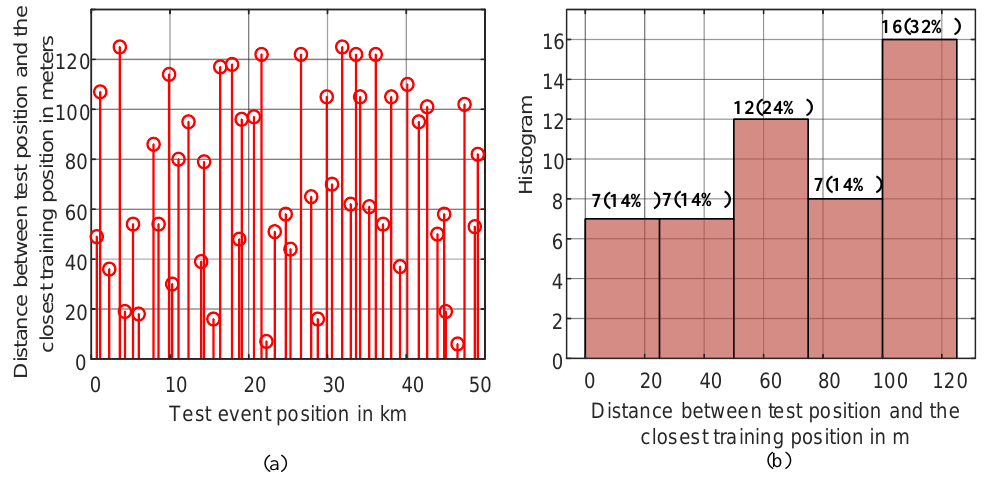
Figure 2. ( a ) Difference between test events’ positions and the training events’ positions, and ( b ) his- togram of the difference distances in Figure 2a. Table 1. Generated dataset for ML training and